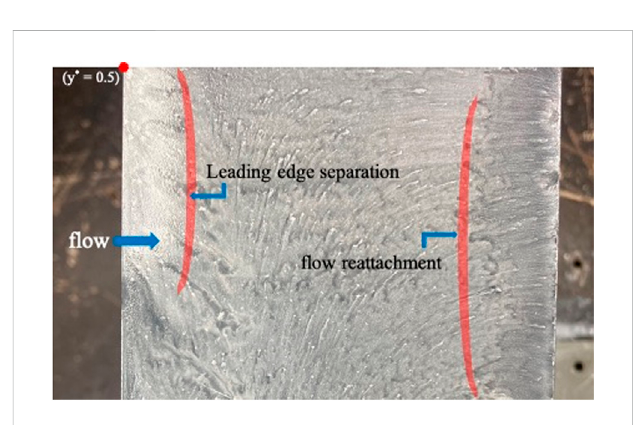
FIGURE 4 Surface oil fl ow pattern for the baseline case at α = 25 °